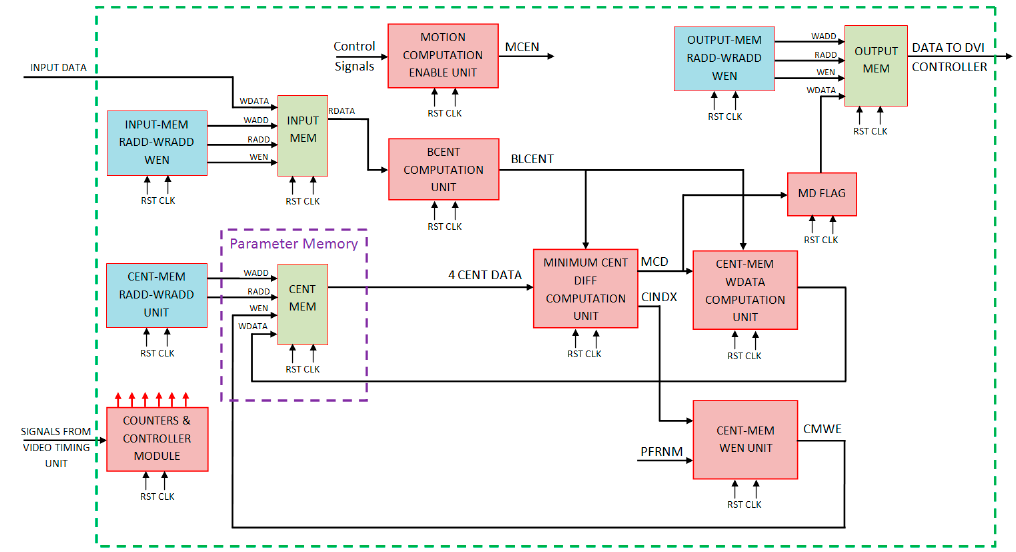
Figure 6. Proposed VLSI architecture for the memory efficient motion detection algorithm.